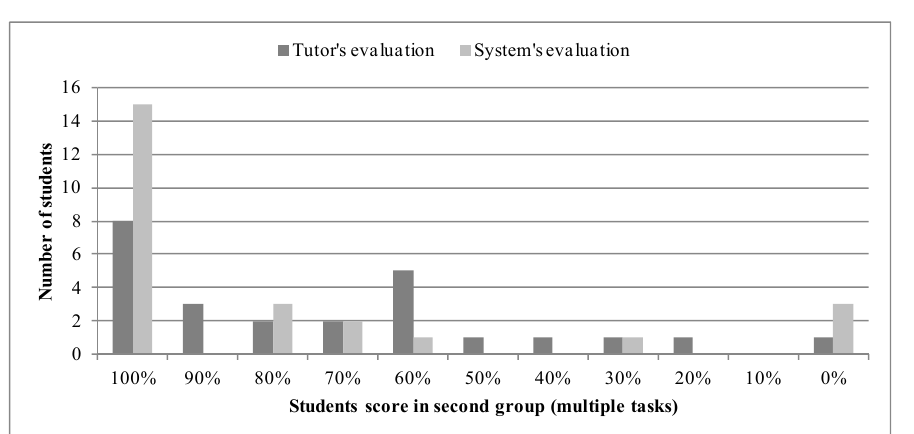
Figure 7. Mark distribution for group 1. Appl. Sci. 2019 , 9 , x FOR PEER REVIEW